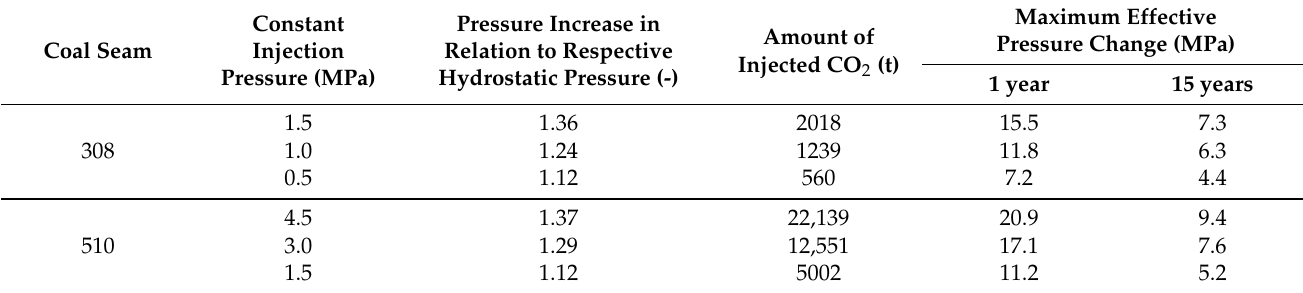
Table 2. Injection and effective pressures as well as the amount of injected CO 2 per single well for the six near-field